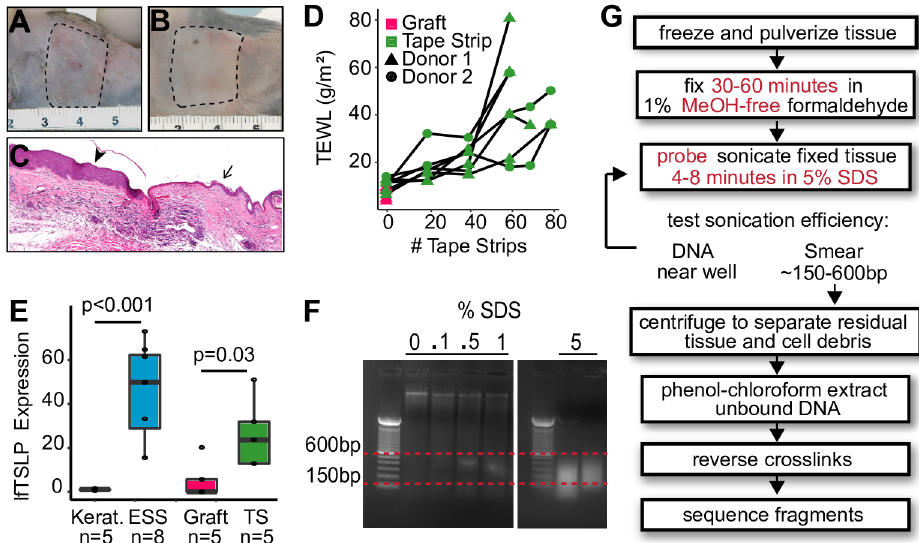
Fig 1. Engineered skin substitute (ESS) asa model to study human barriermaturationand injury. (A) ESS derivedfrom primaryhumankeratinocytes andfibroblasts were graftedonto14 femaleNIH-III mice after two weeksin air-liquidinterface(ALI) culture.Imagewas takentwo weeksafter surgerywhenbandages were removed. (B) Grafts wereallowedto healfor anadditionalfourweeks.(C) Histologyof graftedESS at the junction of the graftedmouseepidermis.Arrowheadindicates graftedhumanESS, arrow pointsto nativemouseskin. (D) Tape-strippingwasperformedon 7 of the mice,with the other 7 as graftedcontrols.Transepidermalwaterloss (TEWL) was usedas an indicator of barrierintegrity. (E) qRT-PCRusinglong-form TSLP -specificprimersof monolayer keratinocytes, ESS at ALI, graftedESS, andin graftedESS 3 hoursafter tape-stripping. Dataare normalized to GAPDHandshownas fold changeoverkeratinocytes; errorbars = standarddeviation. (F) Sonicated ESS DNA runon a 1% agarosegel. Sonication was performedin buffercontaining0, 0.1%, 0.5%, 1%, and5% SDS. (G) FAIRE workflowfor humanepidermis. Modifications from the publishedprotocolareshown with redtext.